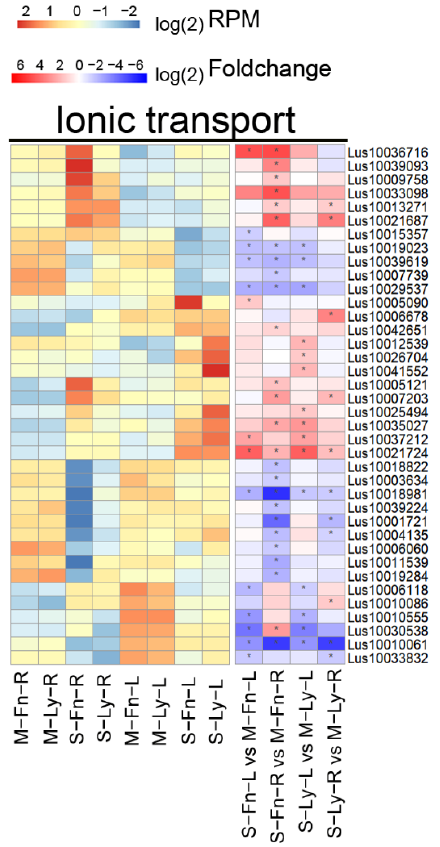
Figure 8. Expression of genes related to ionic transport between root and leaf in Fanni and Longya10 under saline stress. M–Fn–R and M–Ly–R represent the root samples derived from Fanni and under saline stress. M −Fn−R and M −Ly−R represent the root samples derived from Fanni and Longya10 plants, respectively. S −Fn−R and S −Ly−R represent the saline-stress-treated root samples Longya10 plants, respectively. S–Fn–R and S–Ly–R represent the saline-stress-treated root samples derived from Fanni and Longya10 plants, respectively. M−Fn−L and M−Ly−L represent the leaf sam- derived from Fanni and Longya10 plants, respectively. M–Fn–L and M–Ly–L represent the leaf ples derived from Fanni and Longya10 plants, respectively. S−Fn−L and S−Ly−L represent the sa- samples derived from Fanni and Longya10 plants, respectively. S–Fn–L and S–Ly–L represent the line-stress-treated leaf samples derived from Fanni and Longya10 plants, respectively. saline-stress-treated leaf samples derived from Fanni and Longya10 plants,